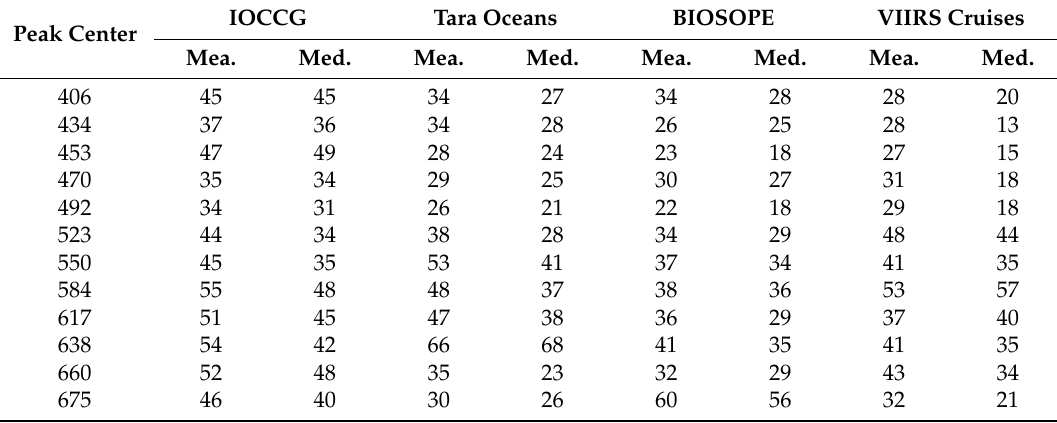
Table 5. Mean (Mea.) and median (Med.) of the unbiased percentage errors for a Gau (λ) retrieval from R rs (λ) for different datasets.